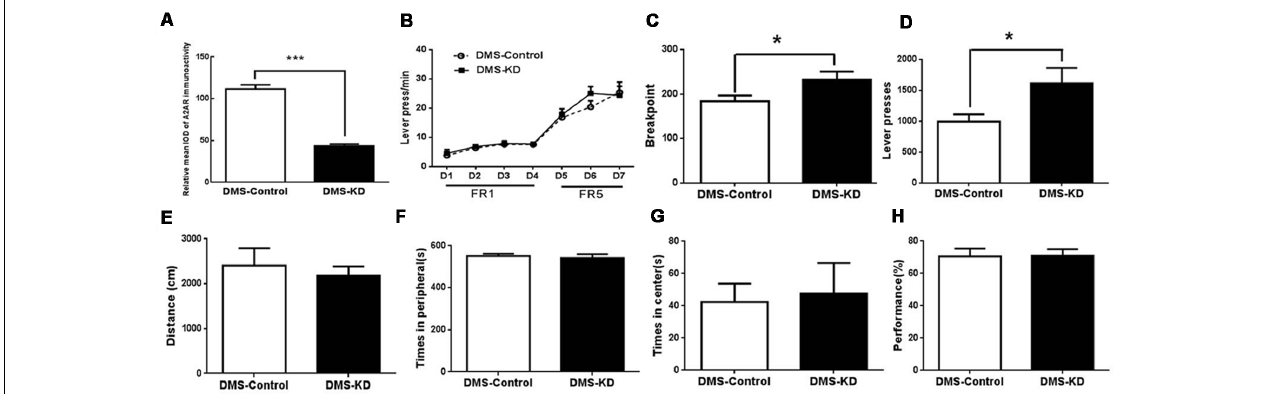
FIGURE 6 | DMS A 2A R KD did not affect locomotion but enhanced motivation. (A) The expression level of DMS A 2A R in these new groups was decreased by ∼ 70% after AAV8-CAG-Cre-ZsGreen transfection. (B–D) DMS A 2A R KD enhanced motivation. (B) There was no significant difference in the training stage between these two groups (effect of training session, F ( 6,96 ) = 51.558, p < 0.05; DMS A 2A R KD × training course interaction effect, F ( 6,96 ) = 1.57, p > 0.05; effect of DMS A 2A R KD, F ( 1,16 ) = 0.6, p > 0.05, two-way ANOVA with repeated measures). (C,D) DMS A 2A R KD increased the breakpoint by 30.6% ( p = 0.0233, Student’s t -test) and a total number of presses by 62.6% ( p = 0.0179, Student’s t -test) in the PRT stage. (E–H) DMS A 2A R KD did not affect locomotion, the residence time in the central and peripheral area in the open-field test, and working memory by a spontaneous alternation in Y-maze, compared to the control (all p > 0.05). ∗ p < 0.05; ∗∗∗ p < 0.001.